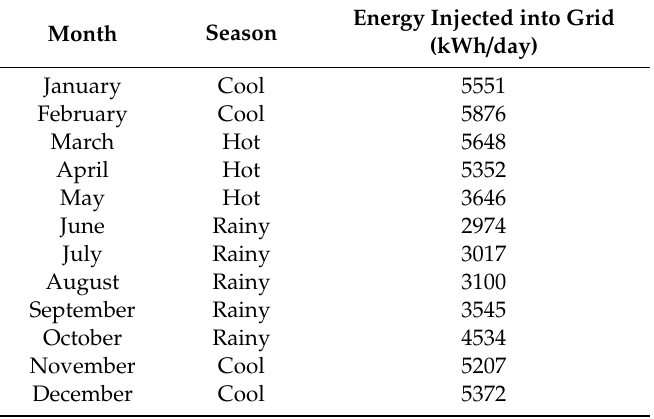
Table 5. Daily average energy injected into the